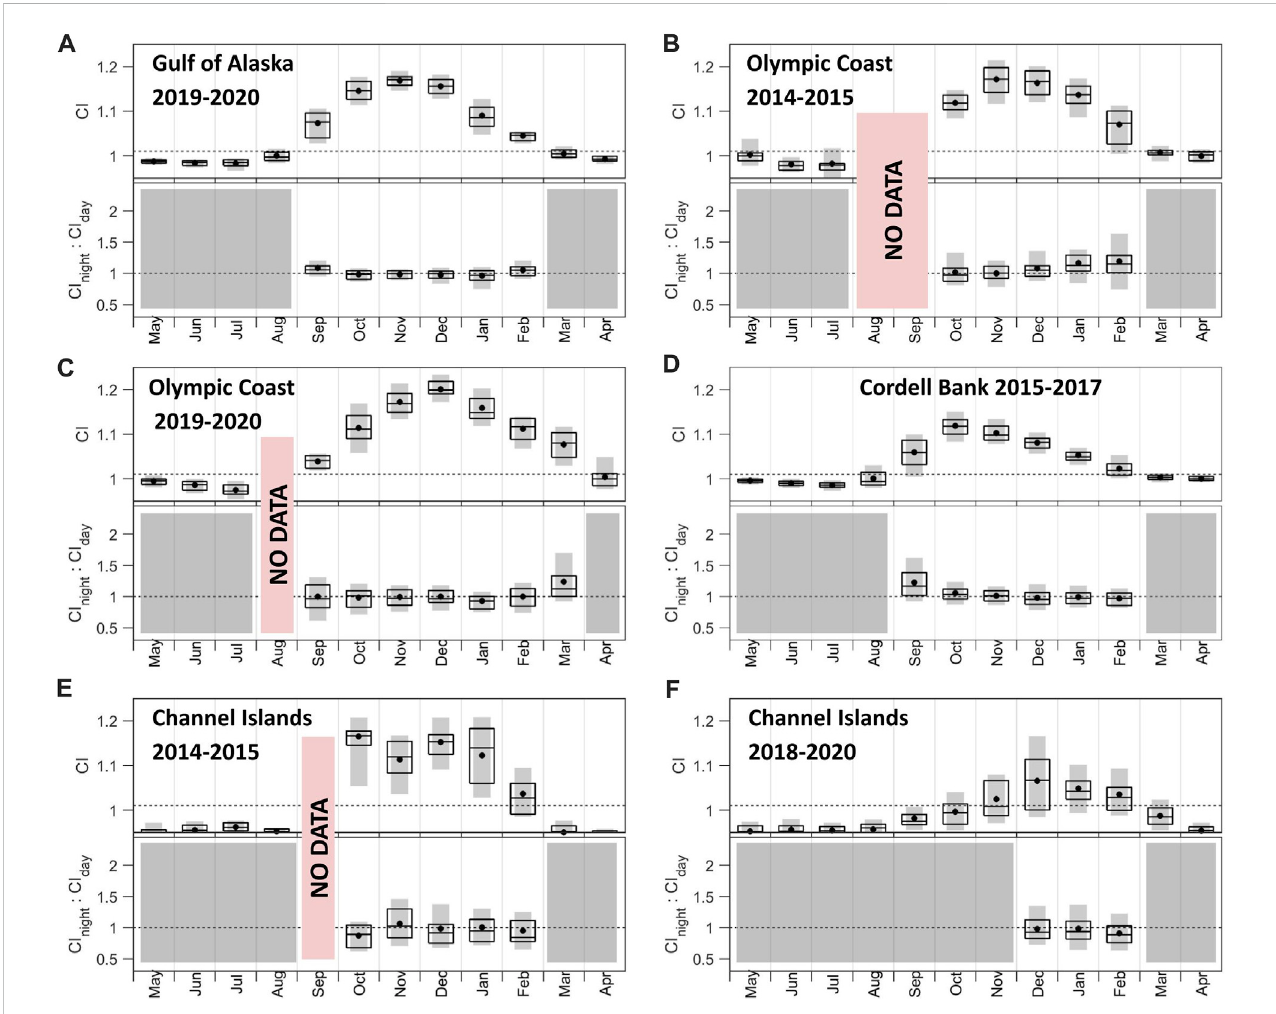
FIGURE 6 Call index (CI) and CI night :CI day associated with fi n whale 20 Hz pulses across (A) Gulf of Alaska 2019 – 2020, (B) Olympic Coast 2014 – 2015, (C) Olympic Coast 2019 – 2020, (D) Cordell Bank 2015 – 2017, (E) Channel Islands 2014 – 2015, and (F) Channel Islands 2018 – 2020 sites. CI night :CI day values were only includedifthemeanCI valuewasabove1.01. Months thatdidnotmeetthisthresholdareshown ingray. Periodsofnodataarenotedinred.The dottedlinein the top plots denotes the threshold for monthly mean CI (1.01). The dotted line in the bottom plots denotes the threshold for daytime song tendency (below than 1) and nighttime song tendency (greater than 1) calling. Boxplots show the 25th, 50th, and 75th percentiles of daily CI values from each month. Blackdotsindicatemeans.Graybarsindicate10th-90thpercentiles.Notethedatashownarenotnecessarilychronologically.SeealsoSupplementaryFigures S2,